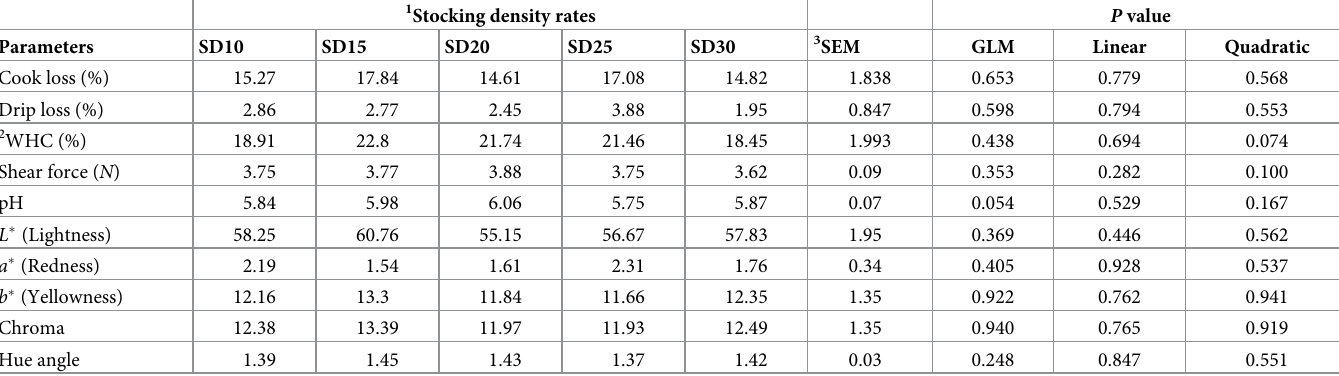
Table 5. The effects of increasing stocking density rates on meat quality parameters of Ross 308 broiler chickens.